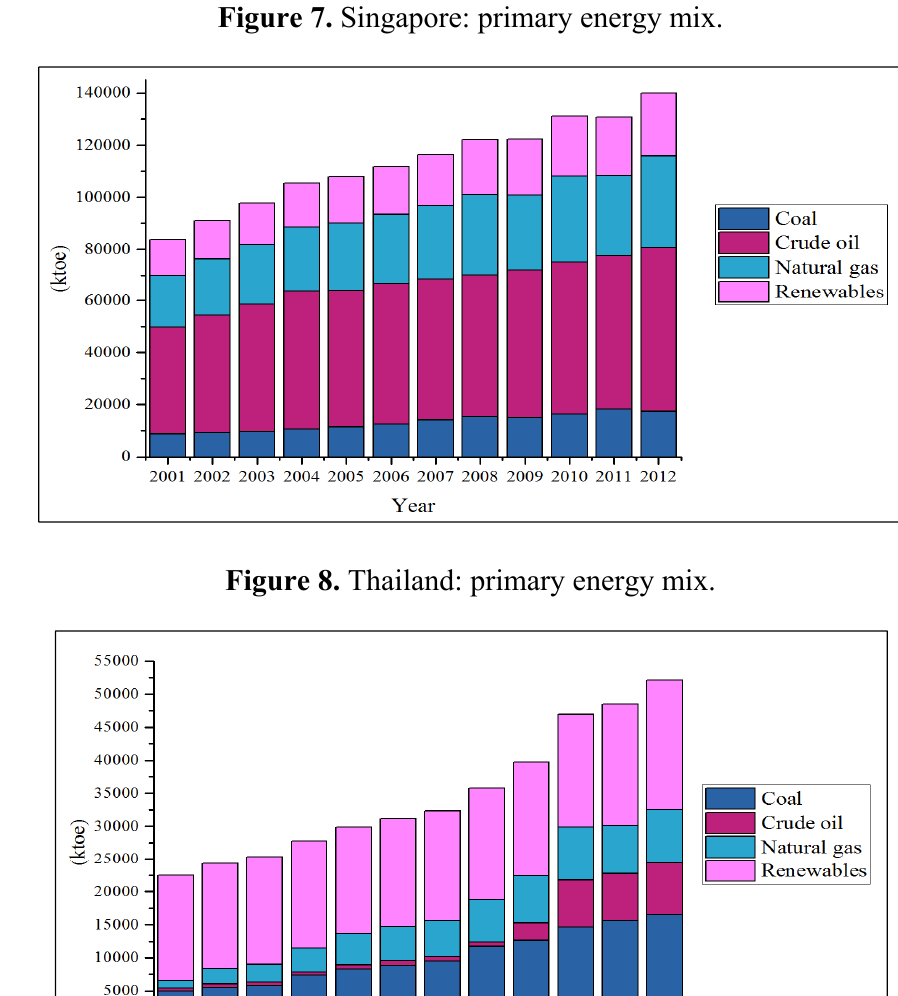
Figure 7. Singapore: primary energy mix.